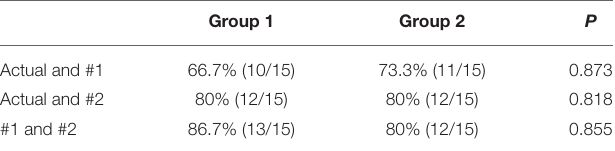
TABLE 3 | Concordance between actual treatment and blind review treatment recommendations, Group 1 (false negative nomogram) and Group 2 (true negative